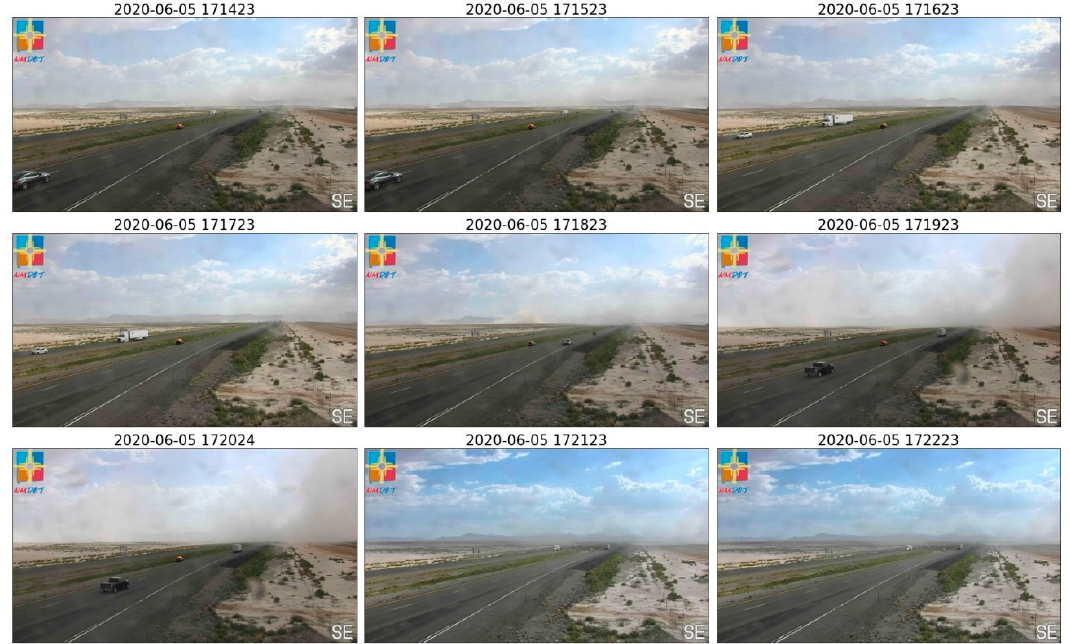
Figure 16. Blowing dust recorded in webcam photos at Lordsburg Playa from NMDOT traffic